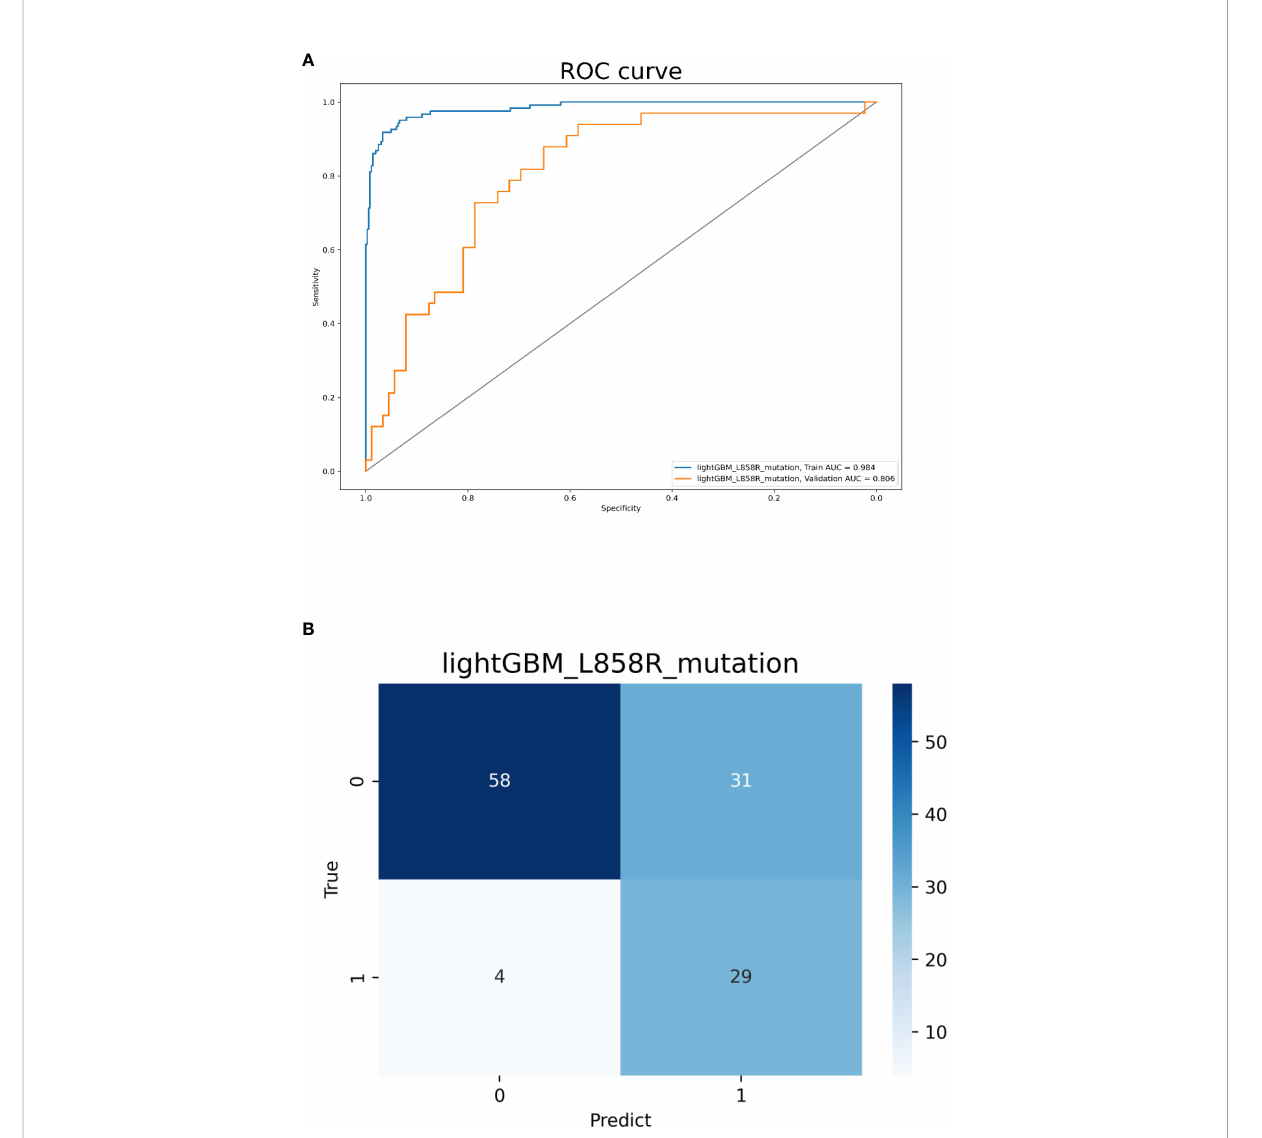
FIGURE 5 Model 3 validation. (A) The ROC curves for model 3 to identify L858R mutations. (B) The confusion matrix for model